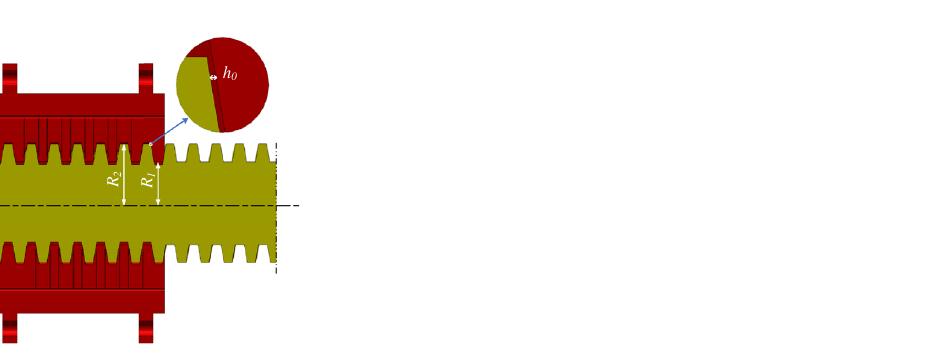
Figure 4. Equivalent drawing of the helix flank surface.